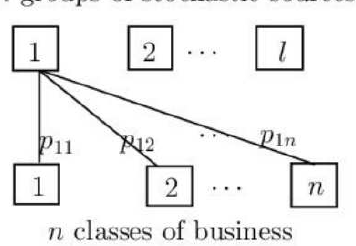
Figure 1. Thinning-dependence